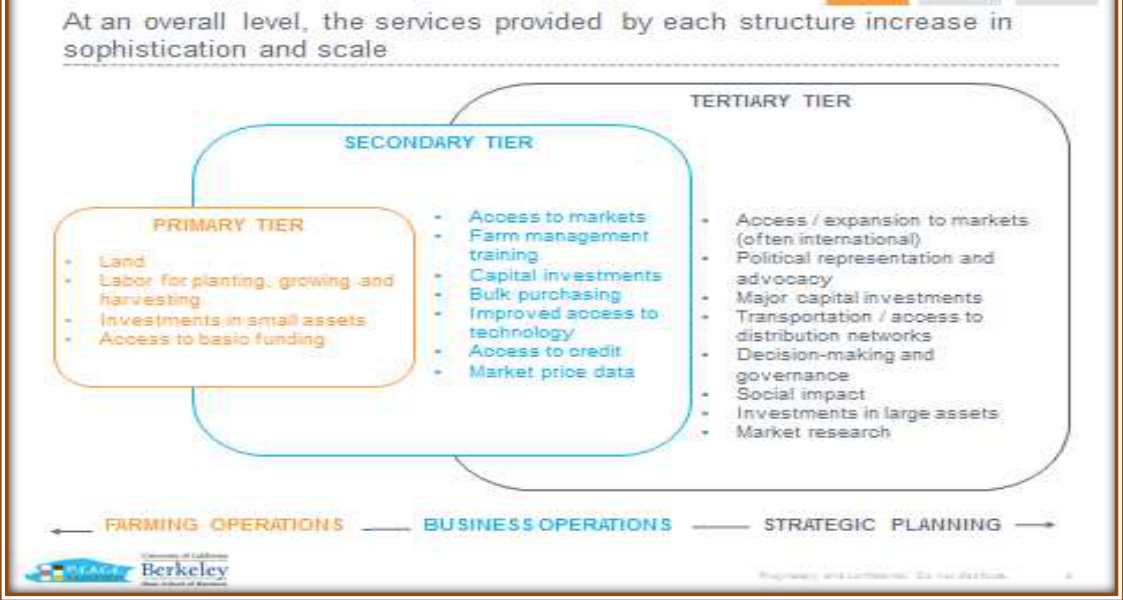
Source: Fujimoto, Hat, Otarola and Sacerdote